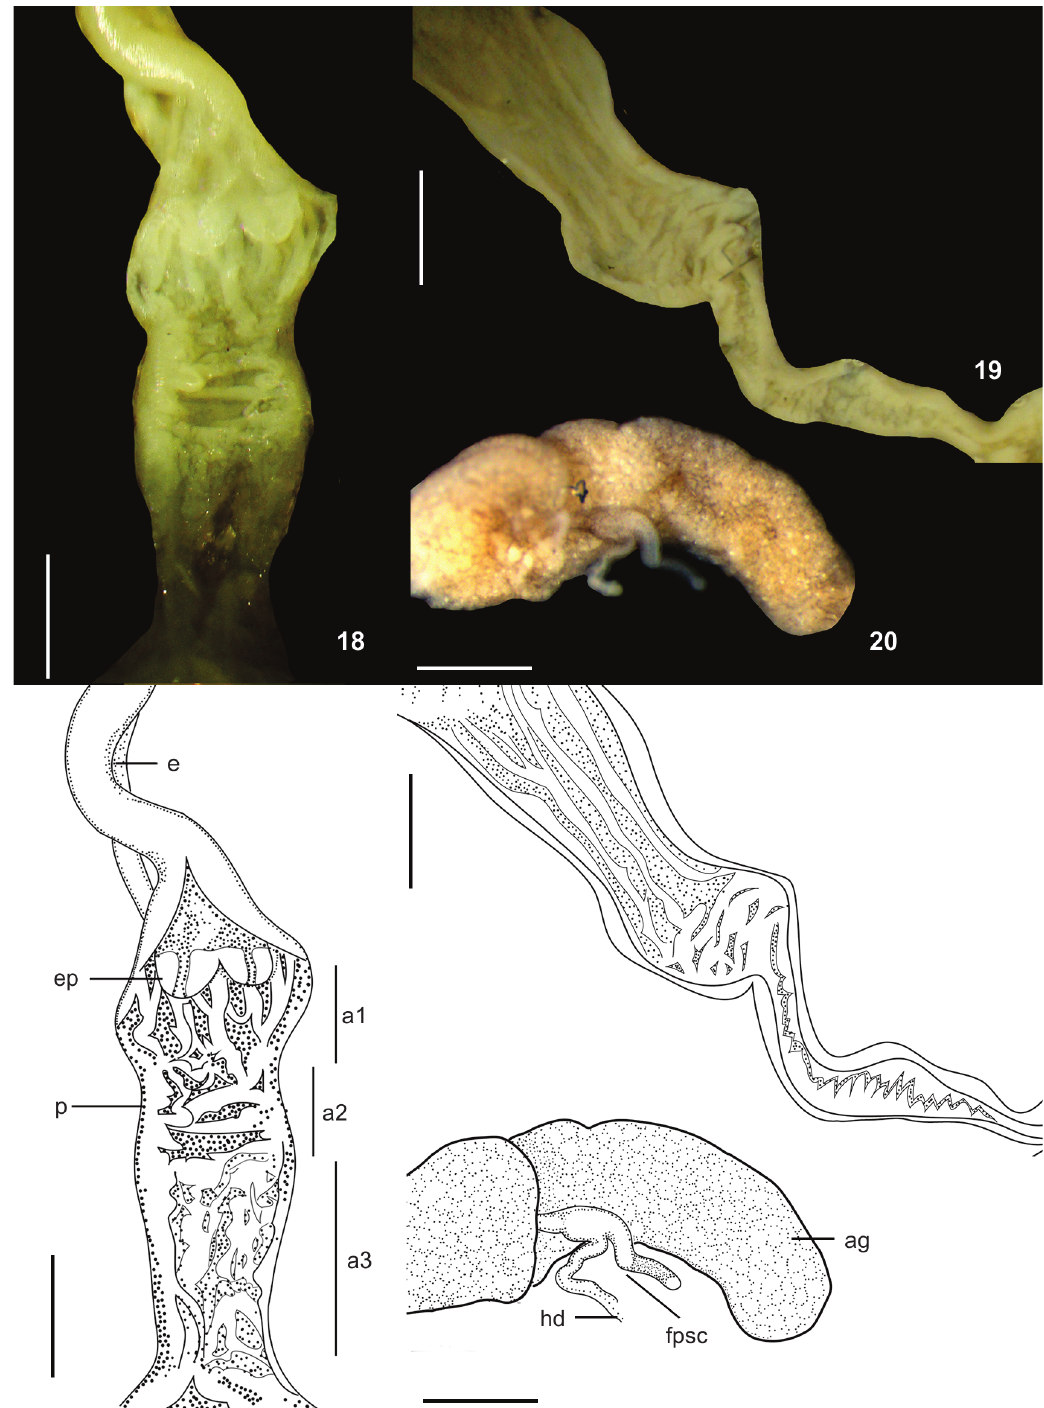
Figures 18–20. Details of the genital system of Ventania avellanedae : (18) internal structure of the penis; (19) internal structure of the bursa copulatrix duct; (20) fertilization pouch–espermathecal complex. (a1) penis area 1, (a2) penis area 2, (a3) penis area 3, (ag) albumen gland. (e) epiphallus, (ep) epiphallic papilla, (fpsc) fertilization pouch-spermathecal complex, (hd) hermaphroditic duct, (p) penis. Scale bar: 1